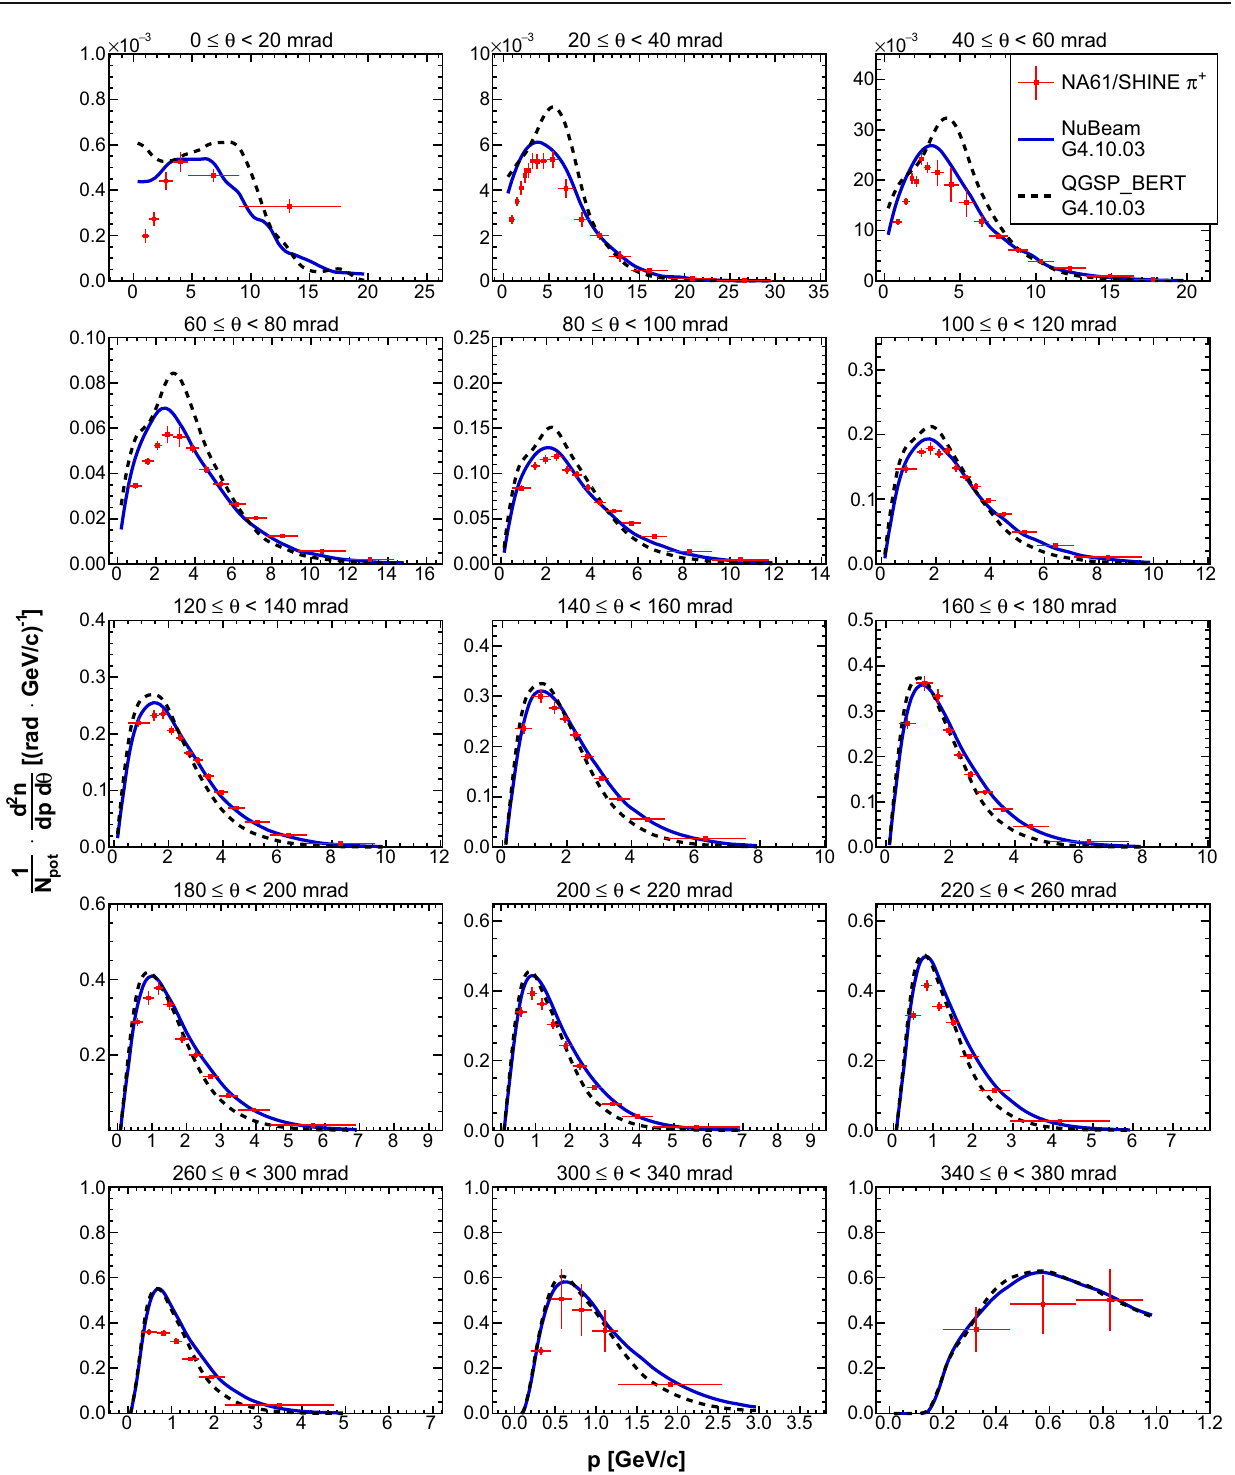
Fig. 23 Double differential yields of positively charged pions for the mostupstreamlongitudinalbin(0 ≤ z < 18cm).Verticalbarsrepresent the total uncertanties. Predictions from the NuBeam (solid blue line)